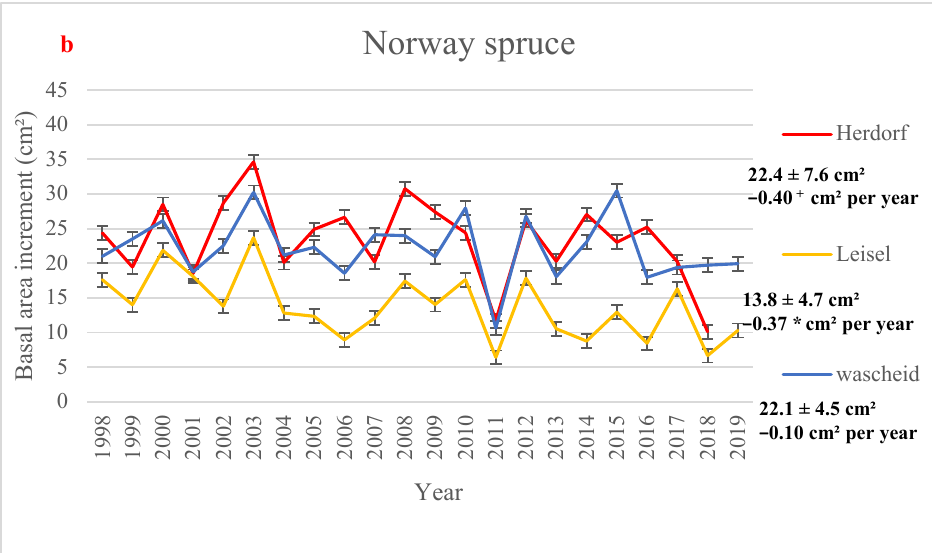
Figure 2. Yearly mean values of basal area increment (in cm 2 ) with 95% confidence intervals ( a ) European beech and ( b ) Norway spruce monitoring sites, averaged over the time period 1998–2019. Mean values, standard deviations (±SD), and the annual trends (Mann-Kendall test) in Basal Area Increment (in cm 2 per year) is showed for all sites over the time period 1998–2019. Significance level: * 0.01 < p < 0.05; + 0.05 < p < 0.1; or p > 0.1.